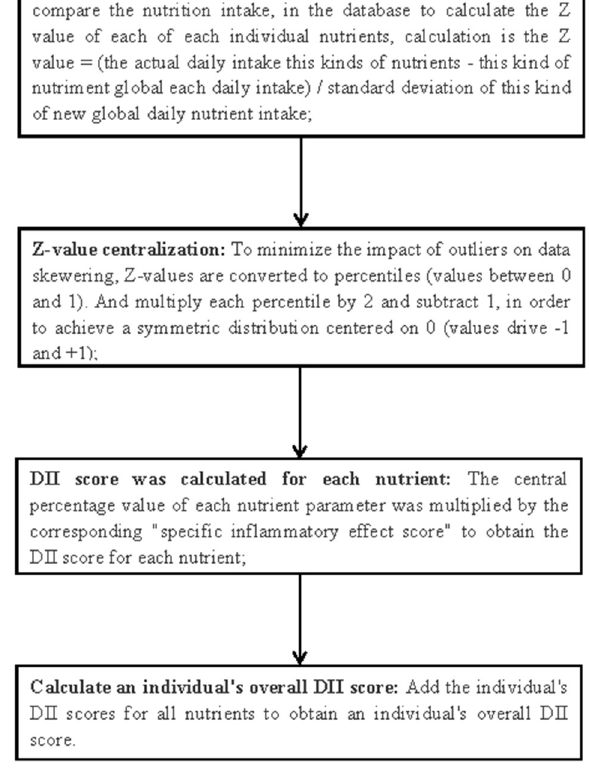
Figure 2. The calculation flow of